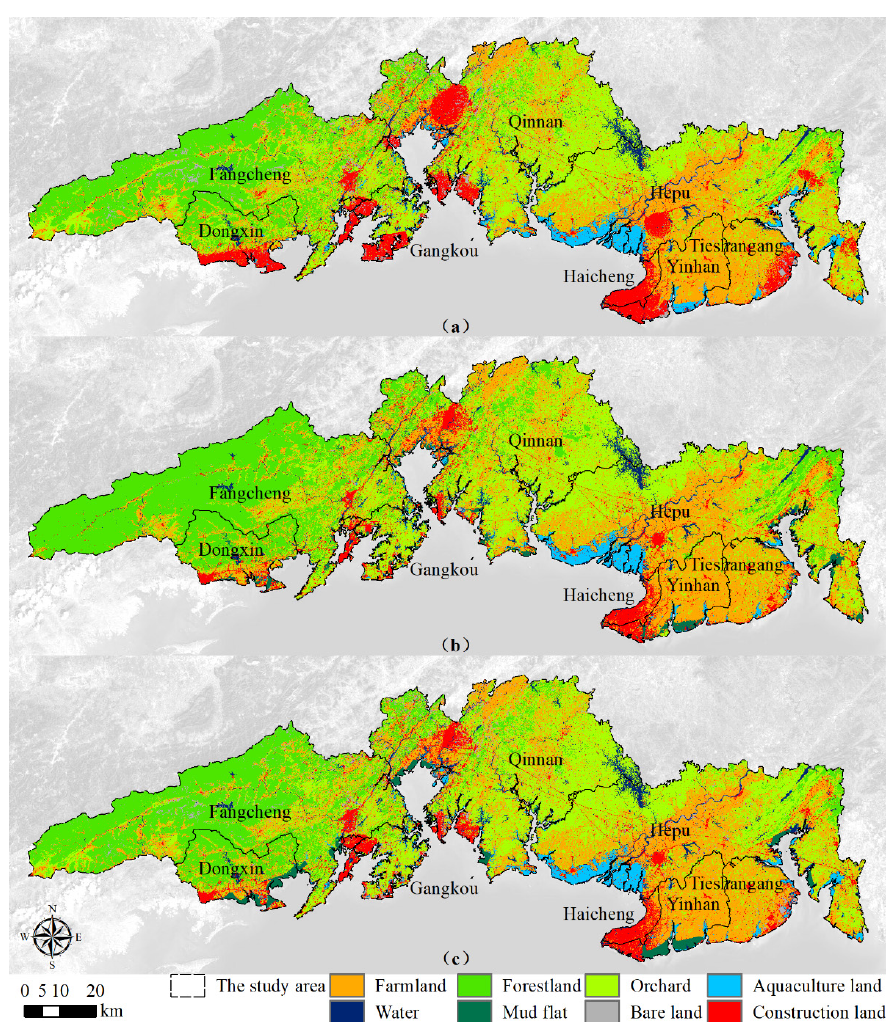
Figure 4. Land use map of the study area in 2030 for the regular growth scenario ( a ), the ecological protection scenario ( b ), and the ecotourism scenario ( c ). protection scenario ( b ), and the ecotourism scenario ( c